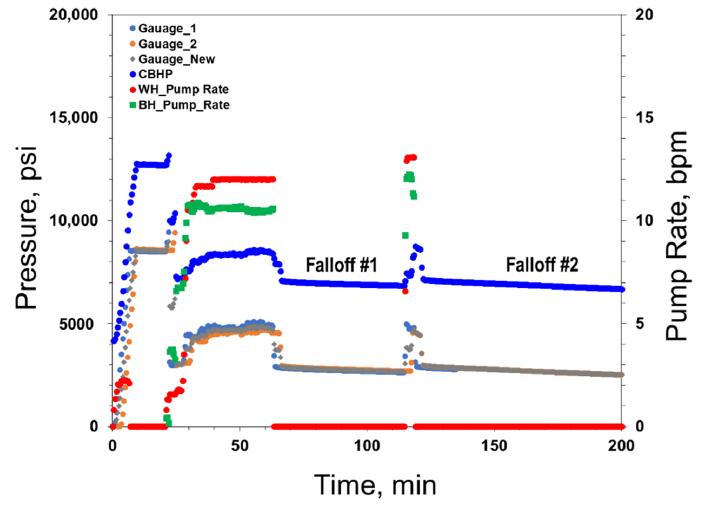
Figure 7. DFIT operations for W2, presenting injection and pressure profiles.